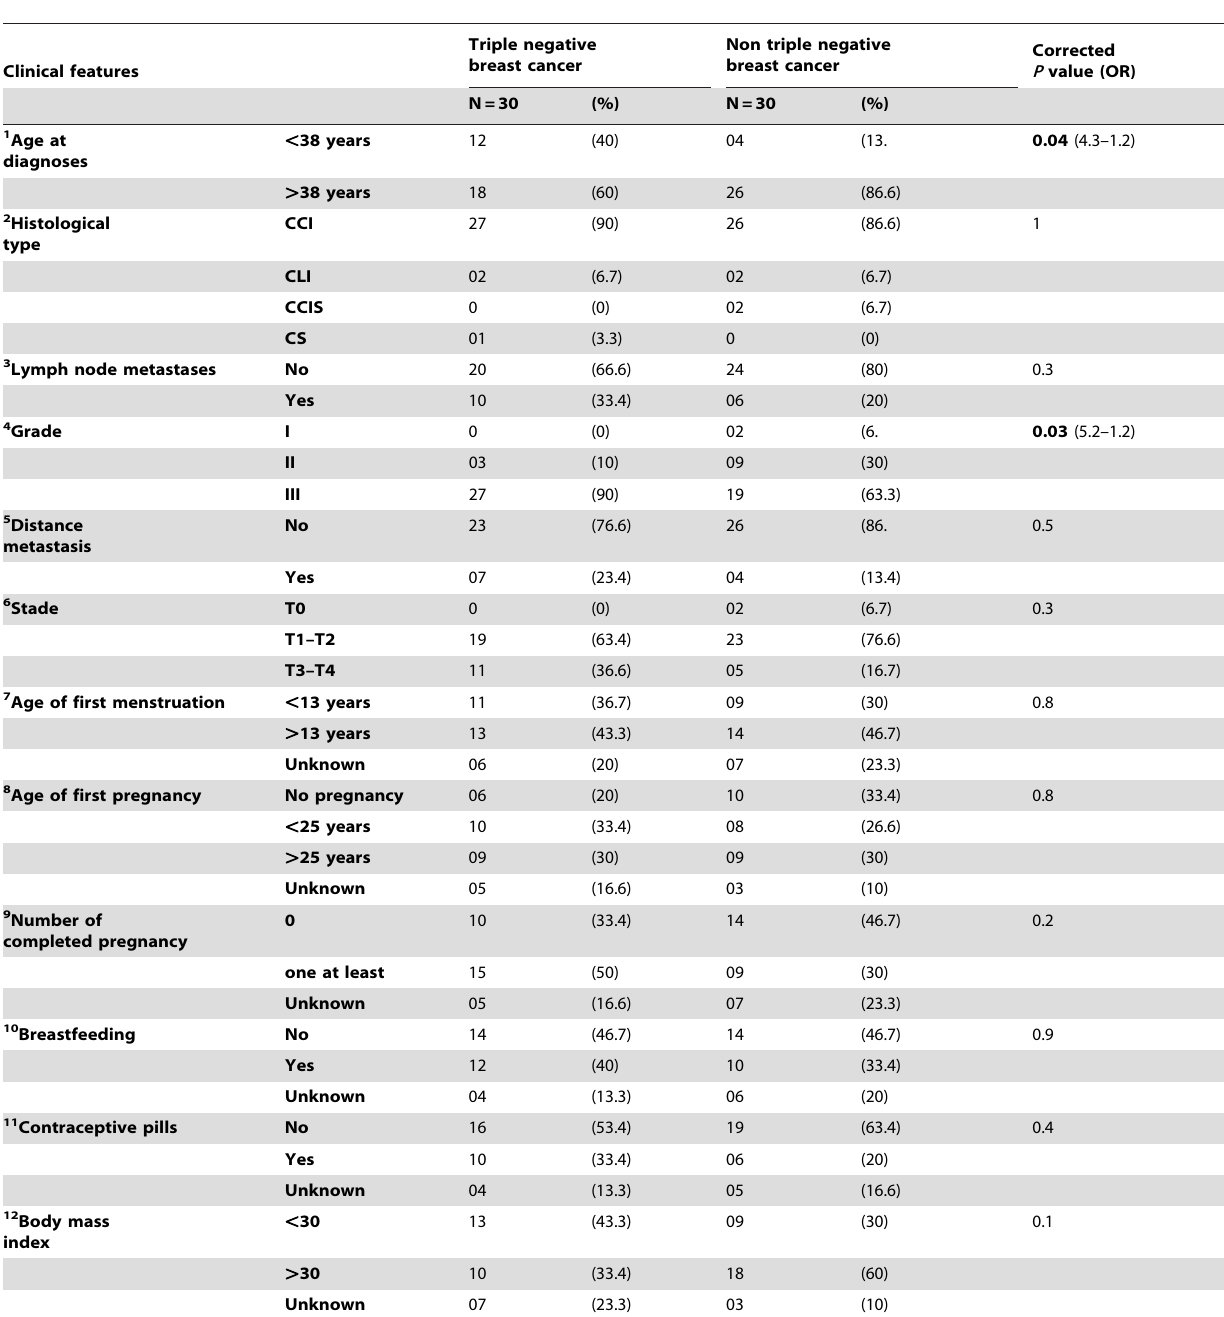
Table 3. Comparison of the clinico-pathological features along with patients’ genico-obstetric history among triple negative and non triple negative mammary